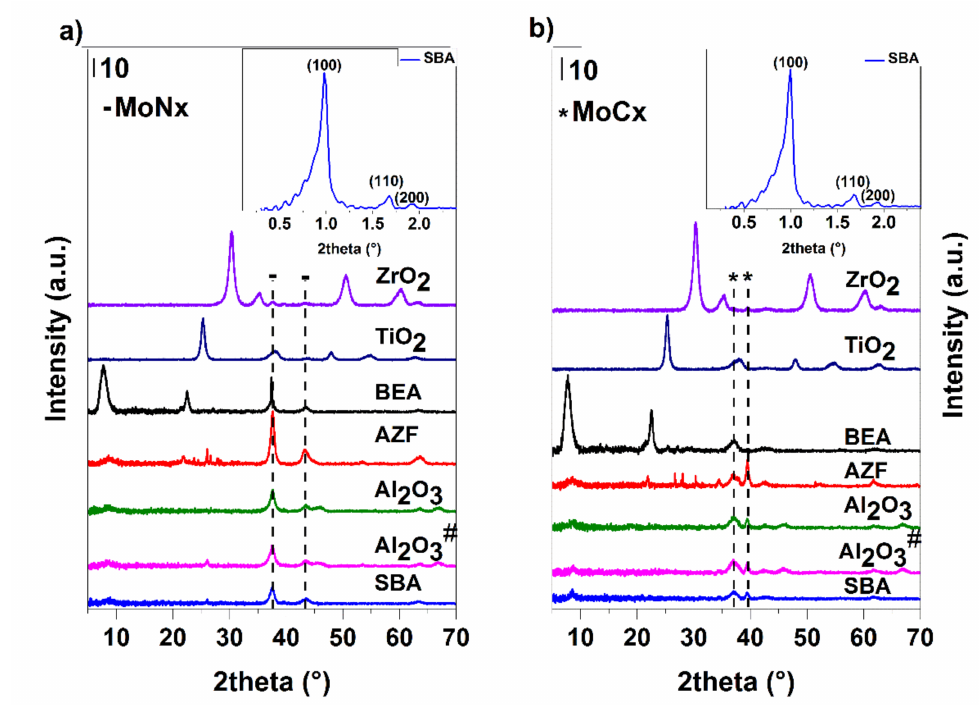
Figure 16. X-ray diffraction patterns of the supported catalysts prepared by different pathways: nitrides ( a ) and carbides ( b ).